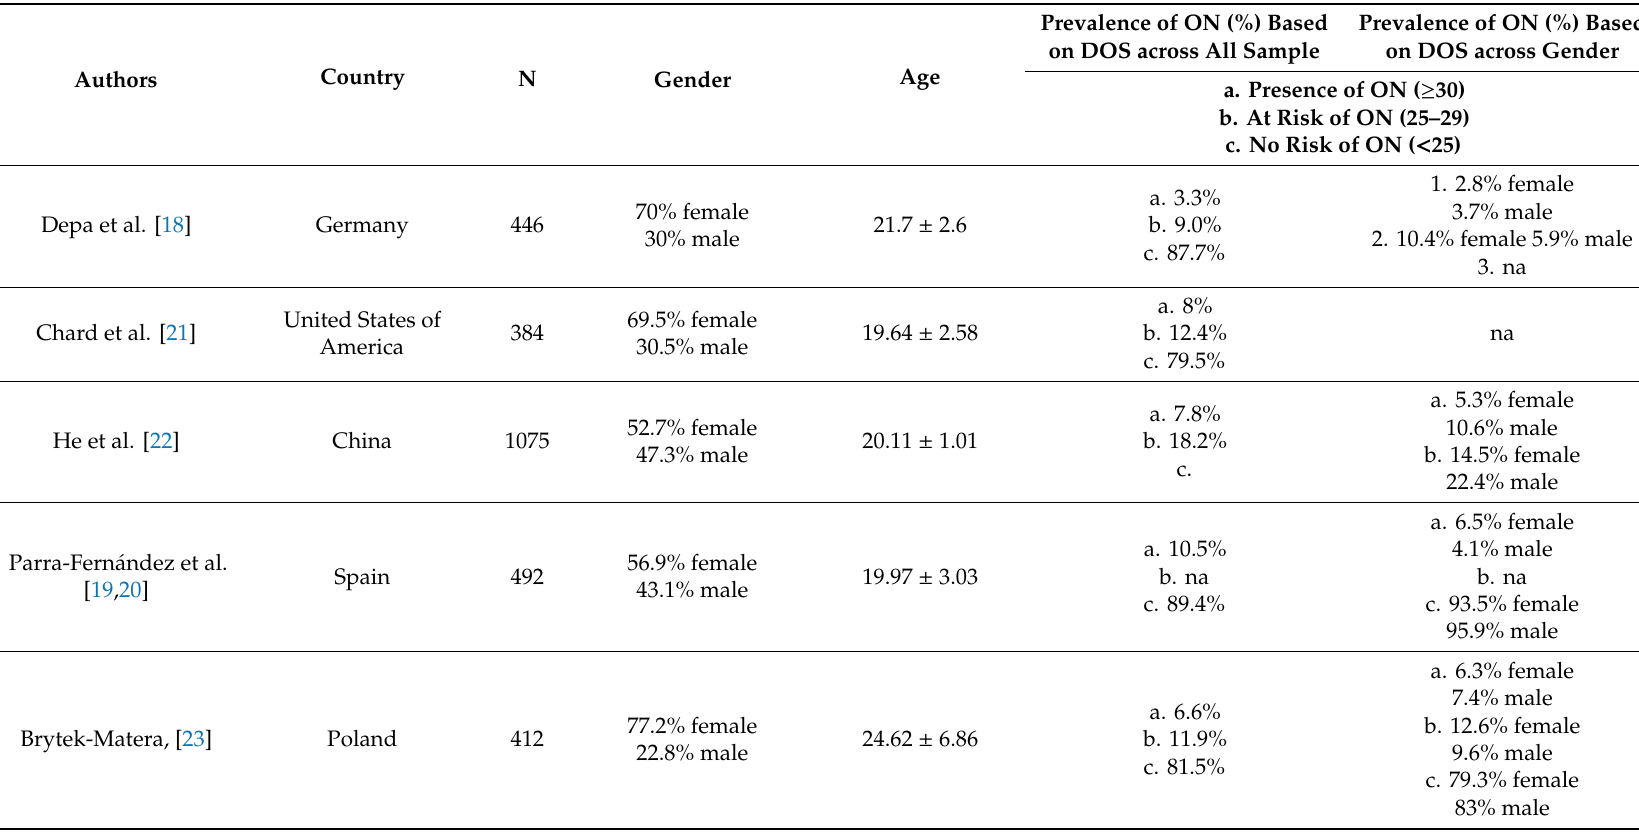
Table 1. Studies assessing orthorexia nervosa (ON) using the Düsseldorf Orthorexia Scale (DOS) among a sample of university students.